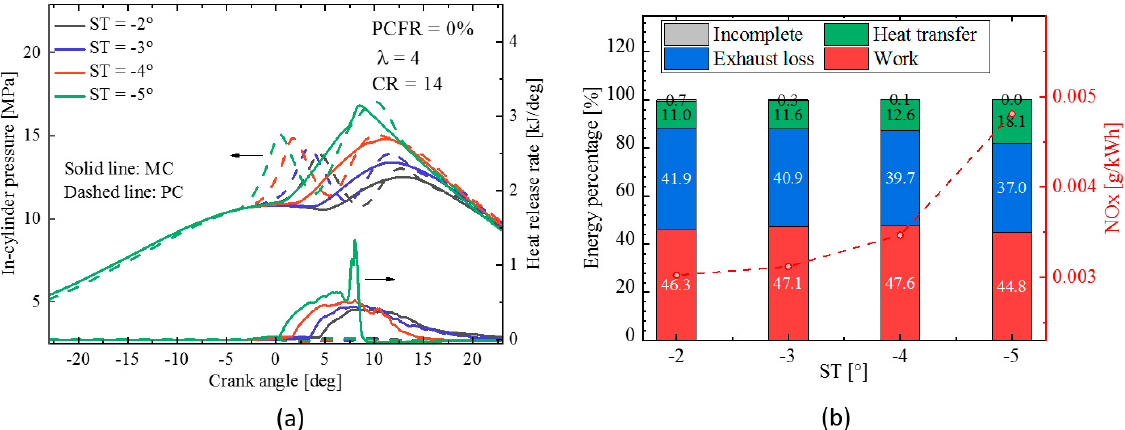
Figure 13. Predicted: ( a ) in-cylinder pressure and heat release rate traces; and ( b ) efficiency for PCFR = 0%, CR = 14, and λ = 4 using different STs.